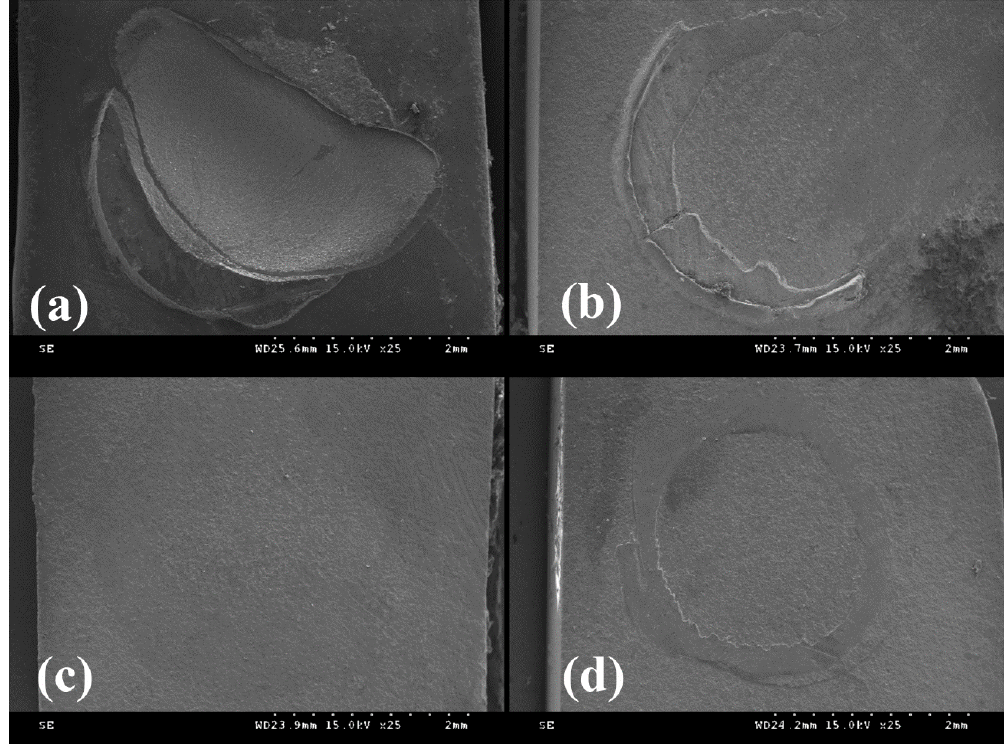
Figure 3. SEM photomicrographs of fractured surfaces: ( a ) Cohesive fracture pattern showed on RXU group with SB; ( b , d ) Mixed fracture pattern showed on RXU L and GC L group; ( c ) Adhesive fracture pattern showed on GC A group.